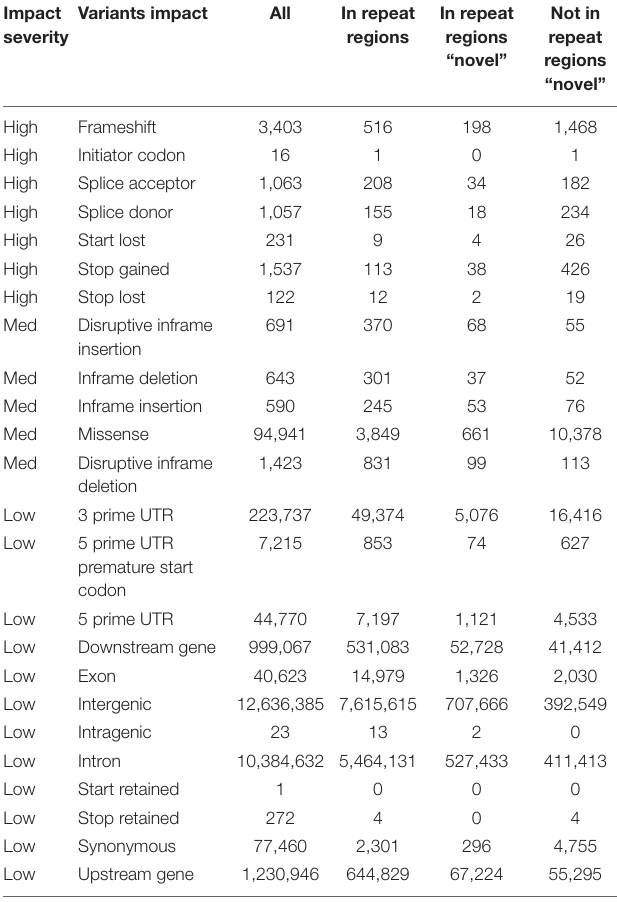
TABLE 4 | Characterization of variants by their GEMINI functional